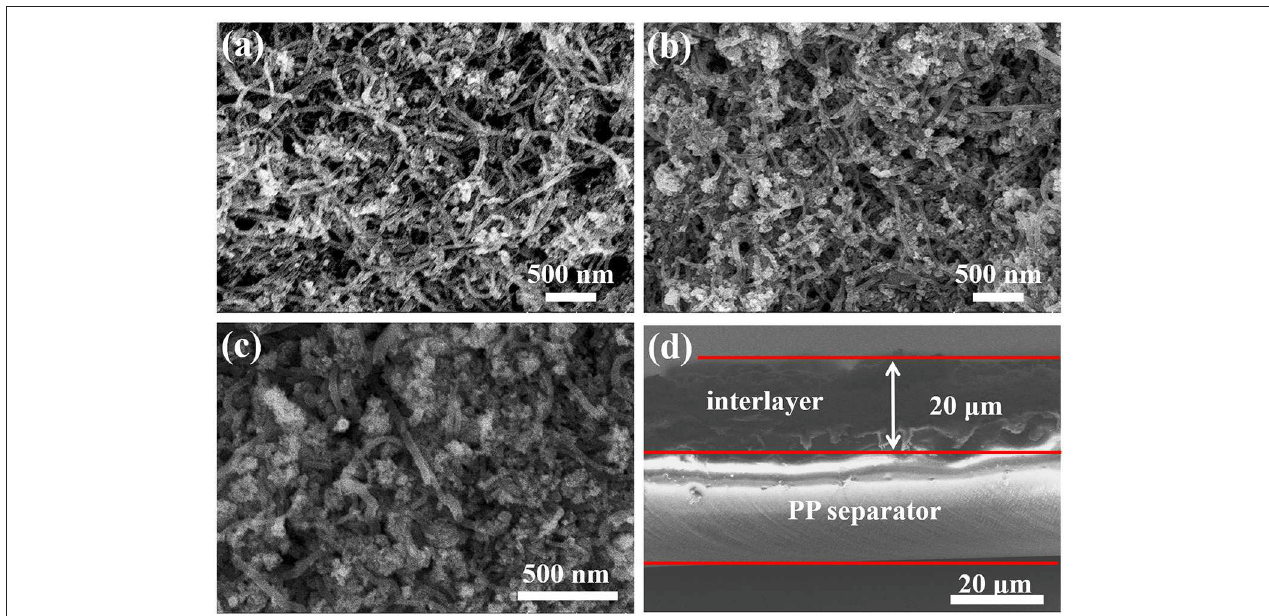
FIGURE 3 | CV curves at various scan rates: the battery with (A) PP, (B) CNTs, (C) FeOOH, and (D) CNTs@FeOOH-II separator, respectively.